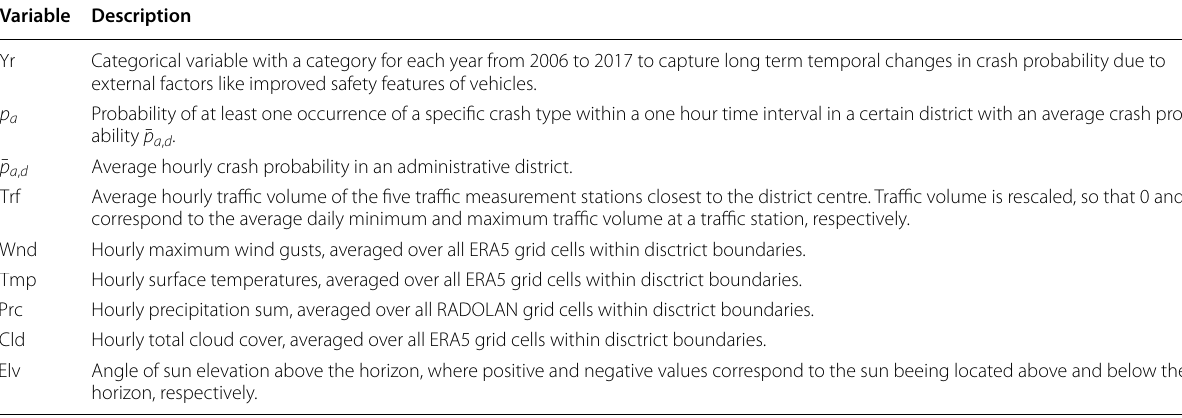
Table 2 Independent variables used in generalized additive models Variable